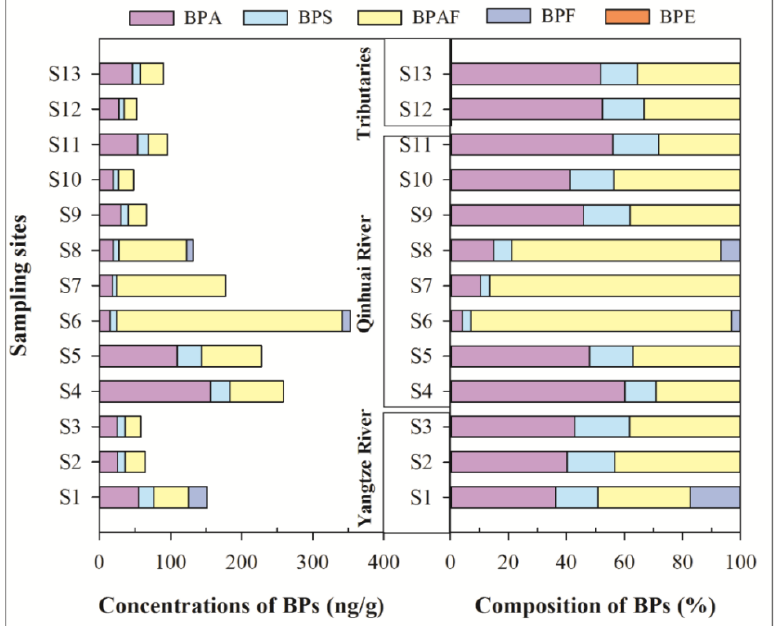
Figure 4. Concentrations and composition of BPs in suspended particulate matter of surface water.